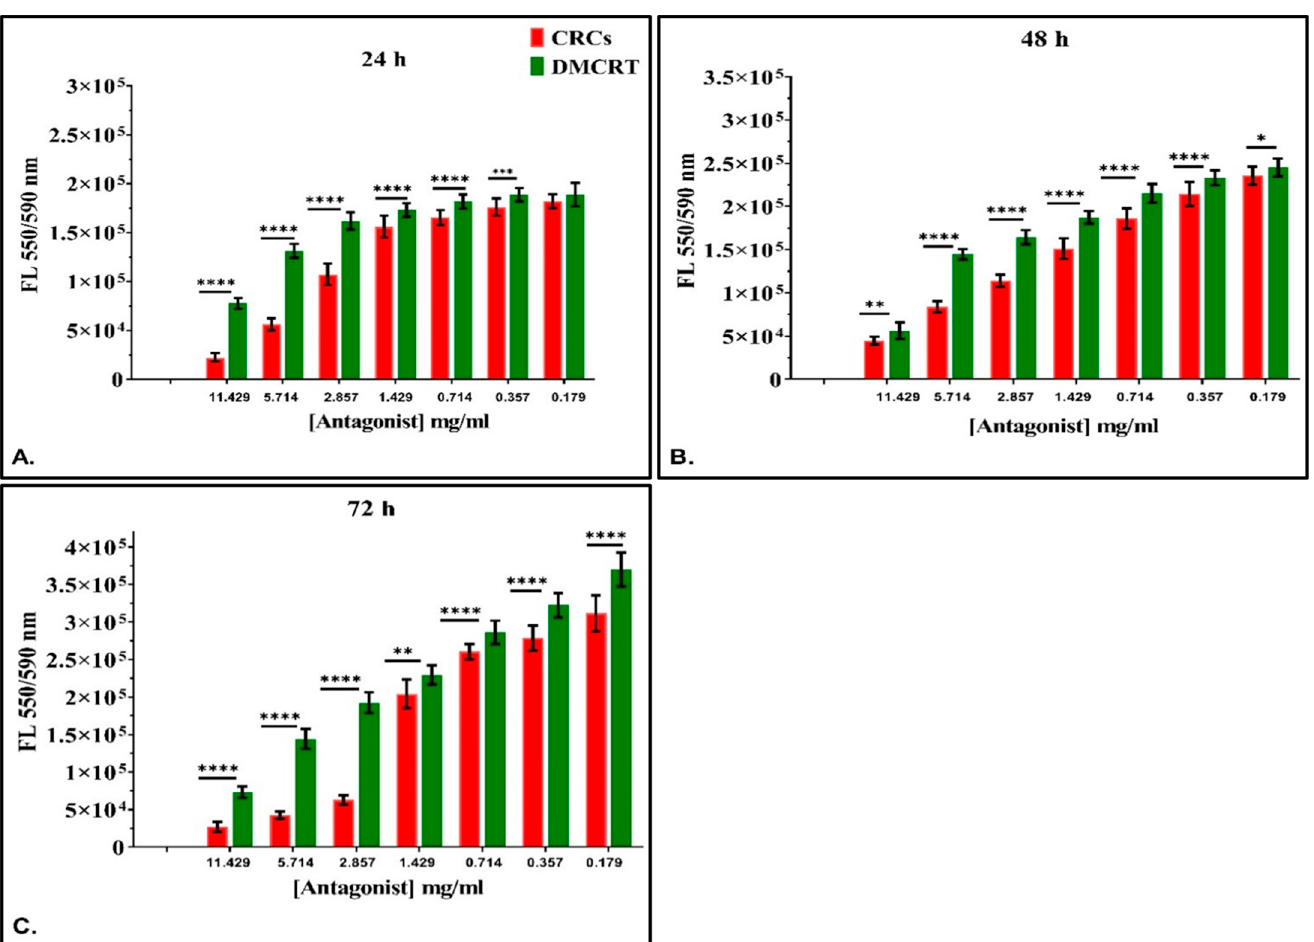
Figure 2. Comparative dose-dependent effect of CRCs and DMCRT on A172 cells. CRCs and DMCRT followed a similar pattern at all time points. CRCs exhibited higher efficacy than DMCRT. This effect was found to be true at all time points that is 24 ( A ), 48 ( B ) and 72 h ( C ) Legend : CRCs : Crocins, DMCRT : dimethylocrocetin, FL : Fluorescence Intensity. Asterisks (*) depict at least p < 0.05 significance level between control experiments and CRCs (* p < 0.05; ** p < 0.01; *** p < 0.001; **** p < 0.0001). Each value represents the mean ± S.D. of triplicate experiments.